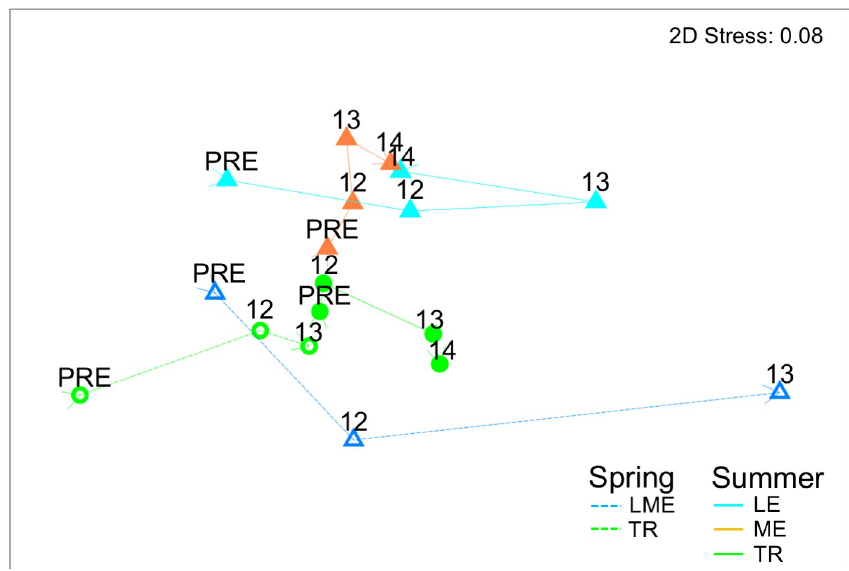
Fig 6. Invertebrate drift nMDS plot of data centroids. Trajectories showing relative direction and magnitude of change by season and river section over time.